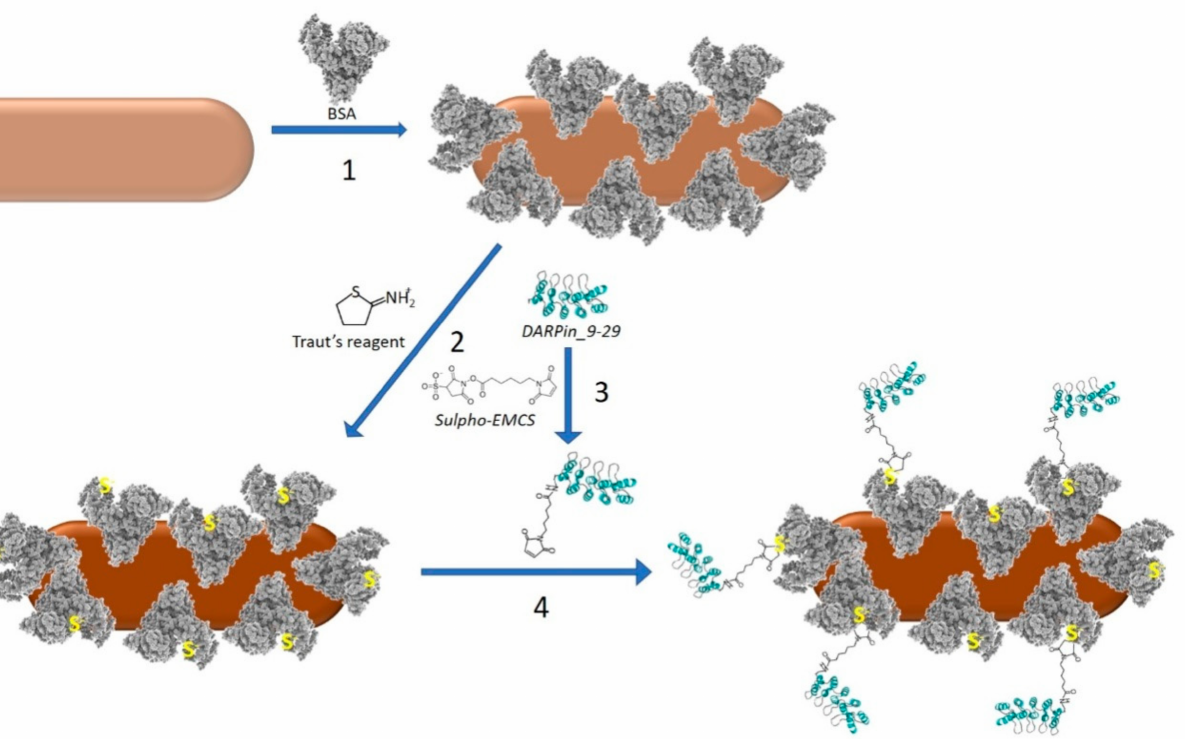
Figure 1. Scheme of DARPin-BSA-GNR synthesis. 1: Coating of a GNR (light brown) with BSA (grey) molecules. 2: Modification of primary amino groups of BSA molecules in the coating layer by Traut’s reagent. This reaction introduces SH groups (shown in yellow) into proteins. 3: Attachment of sulfo-EMCS to one of the primary amino groups of the DARPin (shown in aqua). 4: Covalent attachment of the sulpho-EMCS-modified DARPin molecules to SH groups of the Traut-reagent-treated BSA-coated